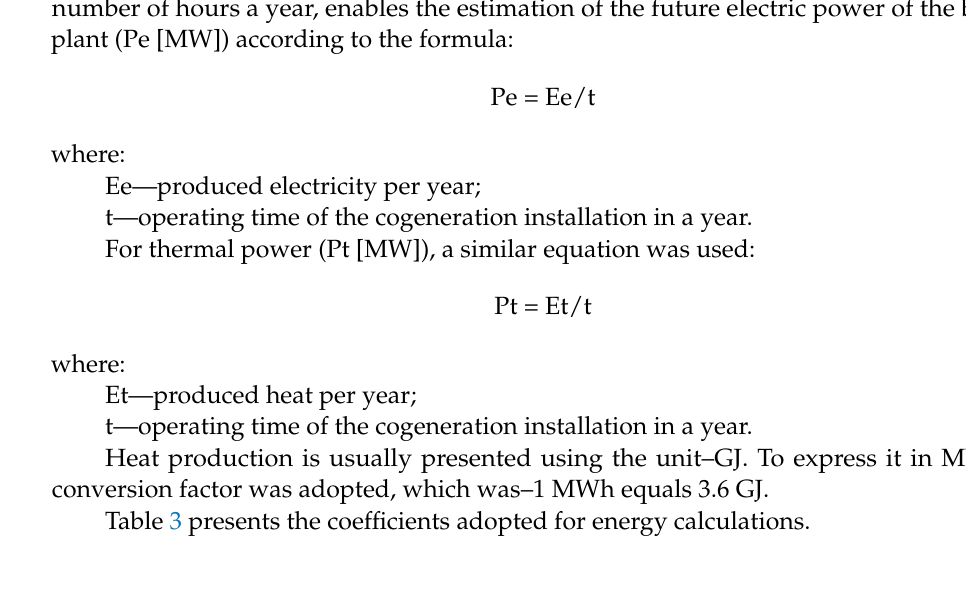
Table 3. Factors used for energy calculation [62].